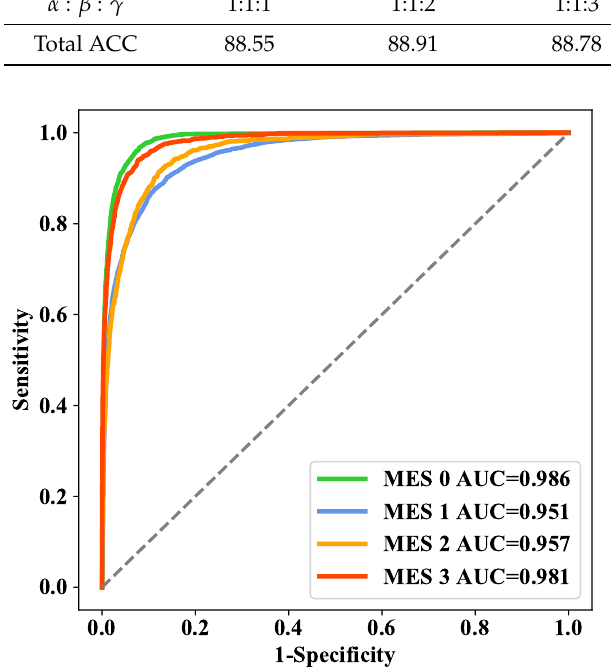
Figure 7. ROC curves for 5-fold